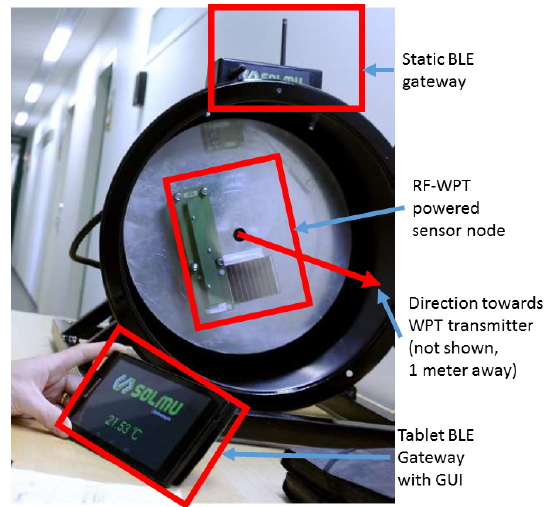
Figure 14. Wireless sensor node application in a rotating environment enabled with wireless power